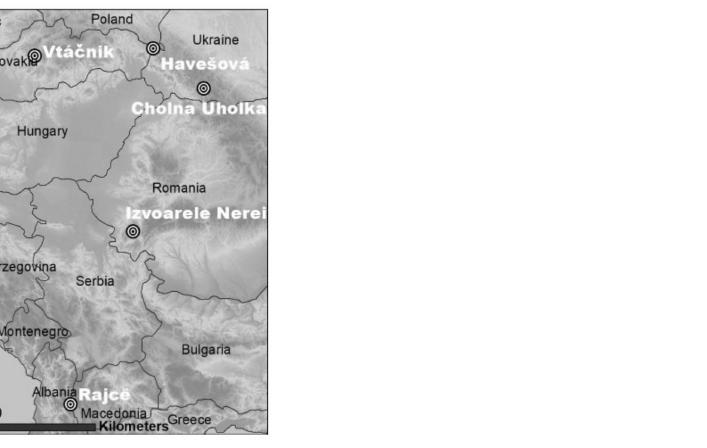
Figure 1. Position of primeval beech forests (marked by black concentric circles) in East-Central, South-Eastern, and Southern Europe. Table 1. Geographical location and climatic characteristics of the research localities. Climate characteristics were collected from [23,24,42–45]. They were adjusted based on the gradient of +50 mm in precipitation, and − 0.5 ◦ C per 100 m gain in altitude in cases where only data from a nearby meteorological station were available. Abbreviations: MAT—mean annual temperature, MAP—mean annual precipitation, AHM—annual heat:moisture index.